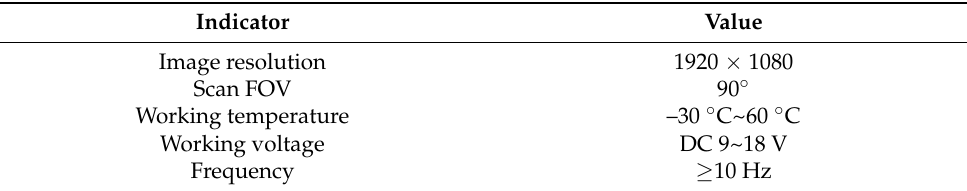
Figure 1. The high-resolution camera installed in a car to collect data of pavement cracks. The specifications of the high-resolution camera are shown in Table 2. Table 2. The specifications of the high-resolution Table 2. The specifications of the high-resolution camera.